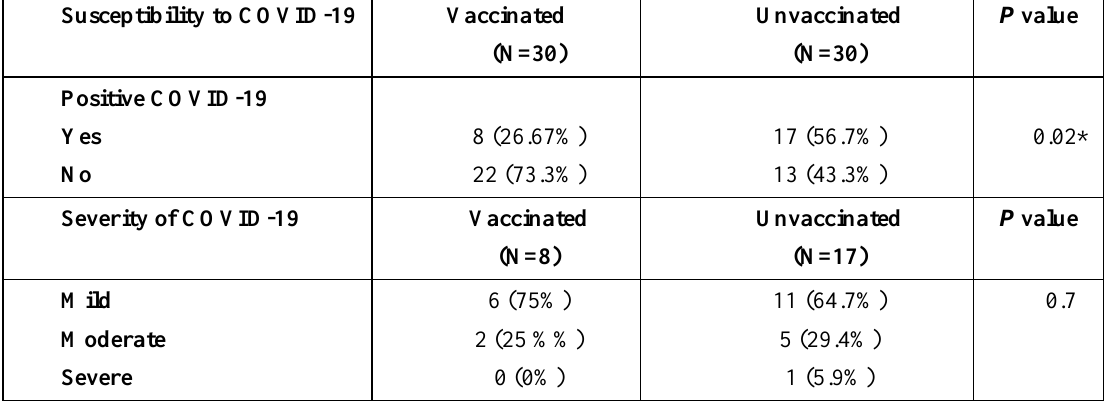
Table II. Susceptibility to and severity of COVID-19 infection among both groups. Susceptibility to COVID-19